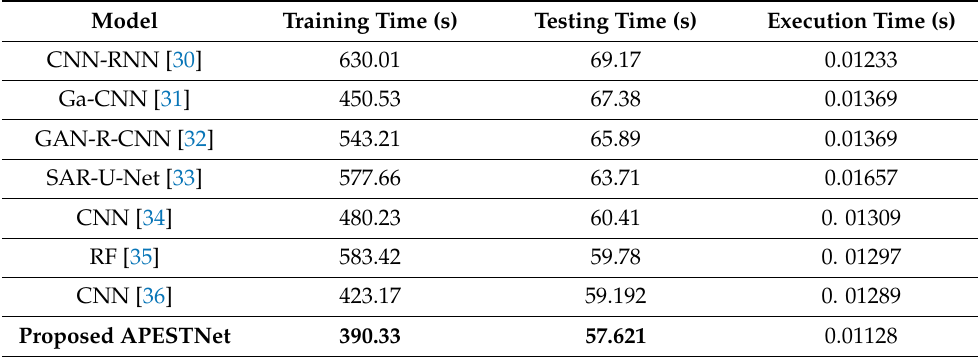
Table 5. Comparison of the proposed model for different time